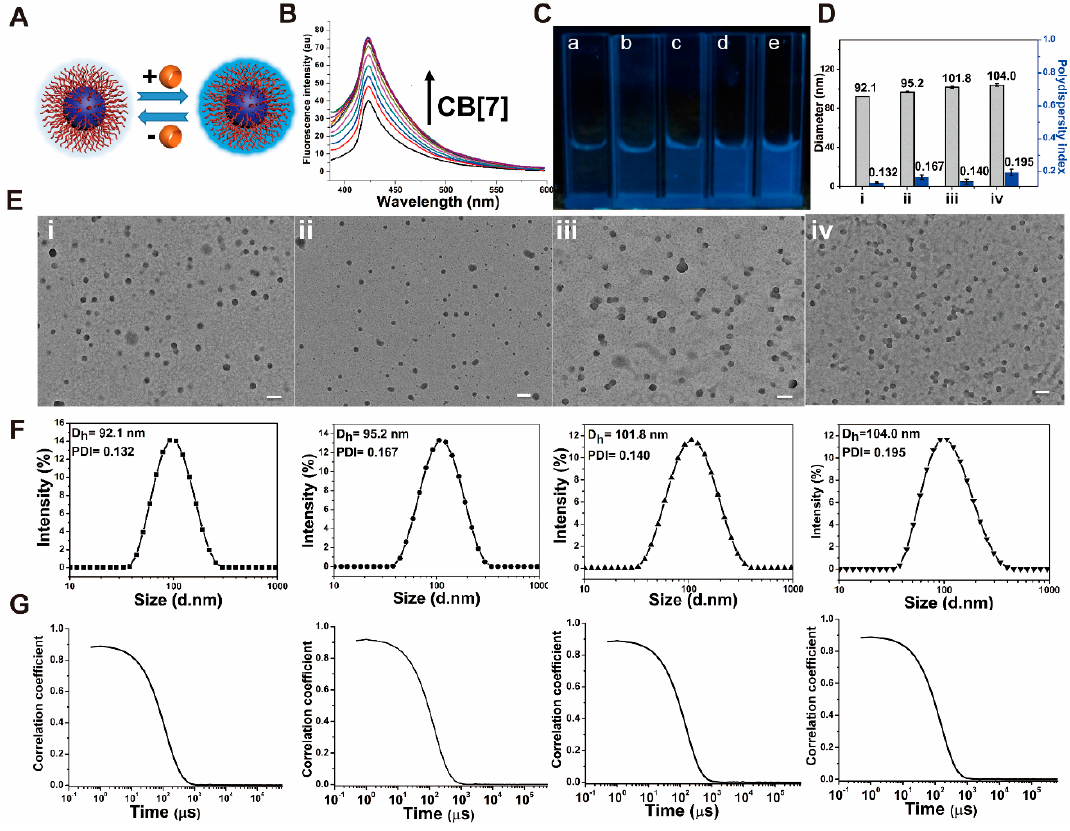
Figure 3. ( A ) Schematic illustration of mPEG- b -QP4VP self-assembly with or without CB[7]. ( B ) Fluorescence spectra of mPEG- b -QP4VP (0.1 mg / mL) with increasing concentrations of CB[7]. ( C ) Photographs of mPEG- b -QP4VP at di ff erent concentrations of CB[7] under 365 nm UV light (a, 1:0; b, 1:0.2; c, 1:0.4; d, 1:0.8; and e, 1:1). ( D ) Hydrodynamic diameter (solid columns) and polydispersity index values (patterned columns) from DLS measurements for the pseudopolyrotaxanes. Average values of three measurements together with standard deviations are presented. ( E ) TEM images of mPEG- b -QP4VP at di ff erent concentrations of CB[7] content (concentration: 0.1 mg · mL − 1 ; pH = 7.0; host:guest = 1:0; 1:0.4; 1:0.8; 1:1 ). Scale bars = 500 nm. ( F ) Intensity-average size distribution for the mPEG- b -QP4VP at di ff erent CB[7] contents together for the hydrodynamic diameter, and the polydispersity index (host:guest = 1:0; 1:0.4; 1:0.8; 1:1 ). ( G ) The autocorrelation curve of the intensity-average size distribution.